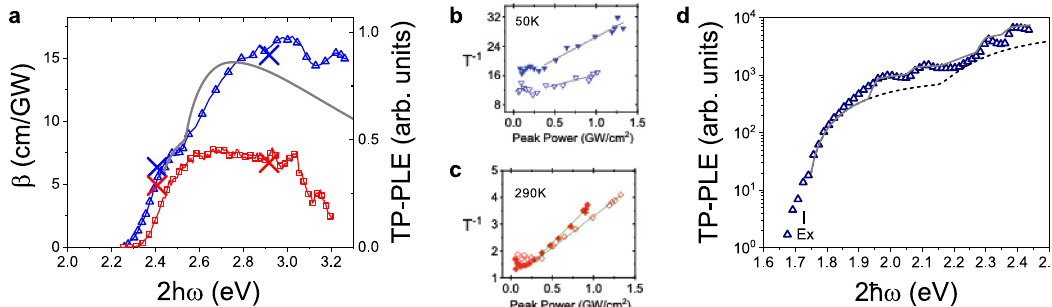
Fig. 4 Rashba splitting in MAPbBr3 and MAPbI3 crystals at low-temperature observed by two-photon photoluminescence excitation (TP-PLE) spectroscopy. a TP-PLE spectrum of MAPbBr 3 at a temperature of 50 K (blue triangles) compared to the room temperature (290 K) spectrum (red squares). The gray solid line is β ð ω Þ calculated including the Rashba effect. The X ’ s on the experimental data indicate the measured values of β using the intensity-dependent transmission measurements shown in ( b and c ). b , c Inverse transmission ( T − 1 ) vs. peak pulse power at 2 _ ω = 2.4 eV (open symbols) and 2 _ ω = 2.9 eV (closed symbols) at temperature of 50 K ( b ) and 290 K ( c ). The solid lines are linear fi ts to the data with slopes proportional to β . d TP- PLE spectrum of MAPbI 3 at a temperature of 77 K (blue triangles) plotted on a semi-log scale. The lines are β ð ω Þ calculated excluding (dashed black) and including (solid gray) the Rashba effect. The position of the exciton (Ex) is